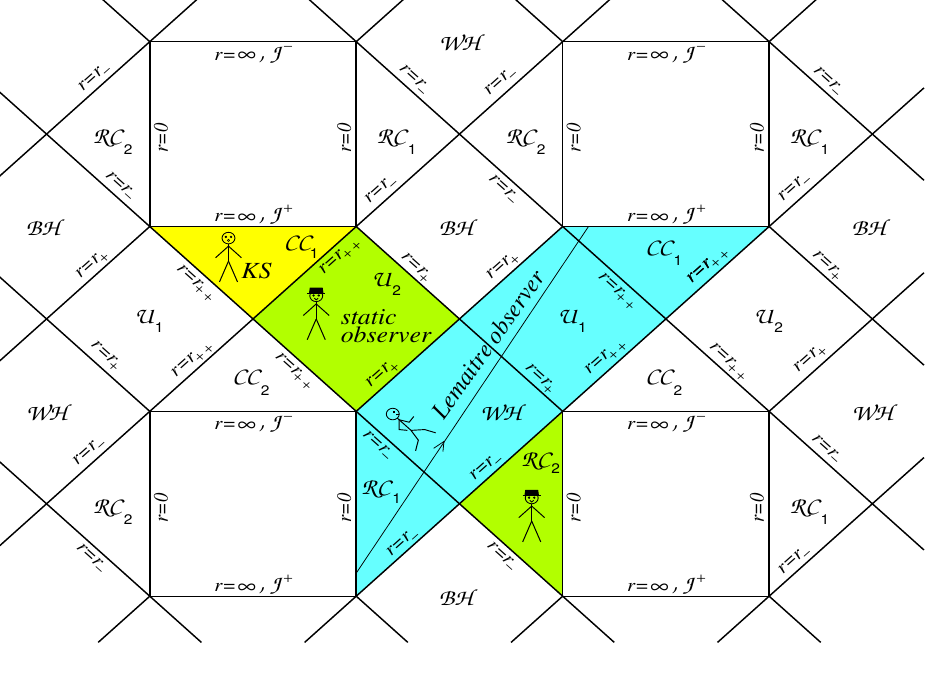
Figure 5. Fragment of the global structure of regular spacetime with 3